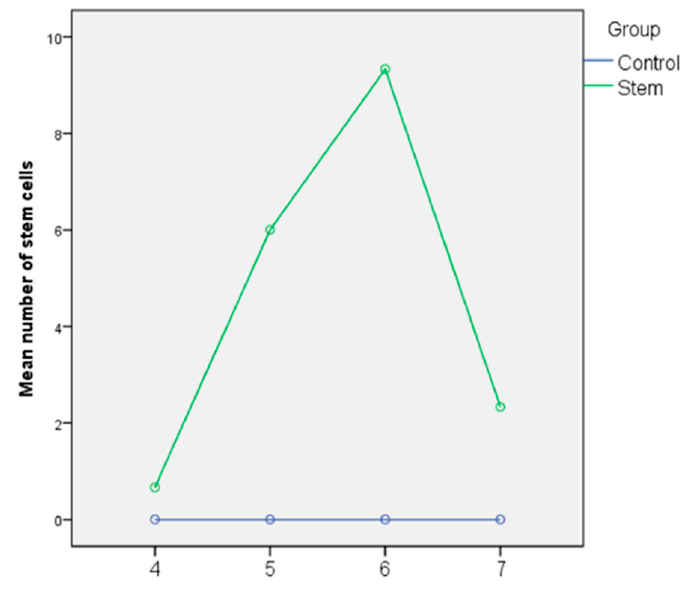
Figure 3. Number of MSCs evolution (CRS mouse model daily distribution)-Comparison with the control group. Table 4. MSC Group Statistics.